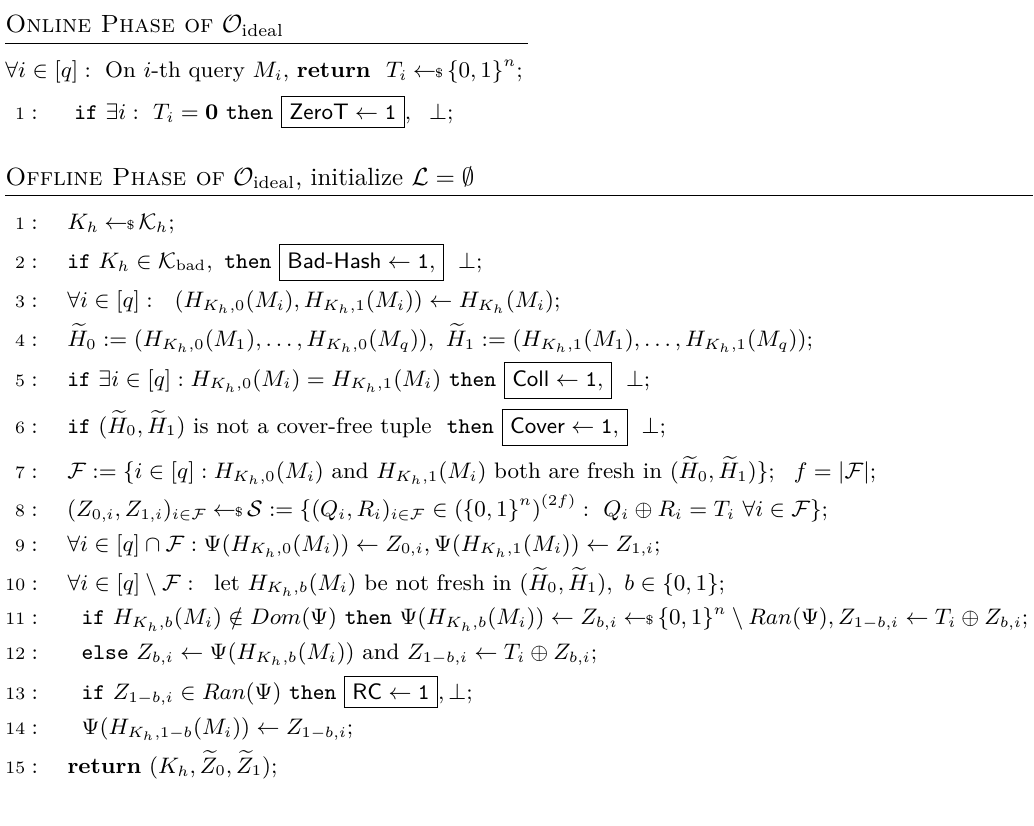
( M i ) = H K ( M j ) or H K ( M i ) = H K ( M j ) h ,b h ,b h ,b h , 1 − b ( M i ) is not defined yet. e Z 0 denotes h ,b